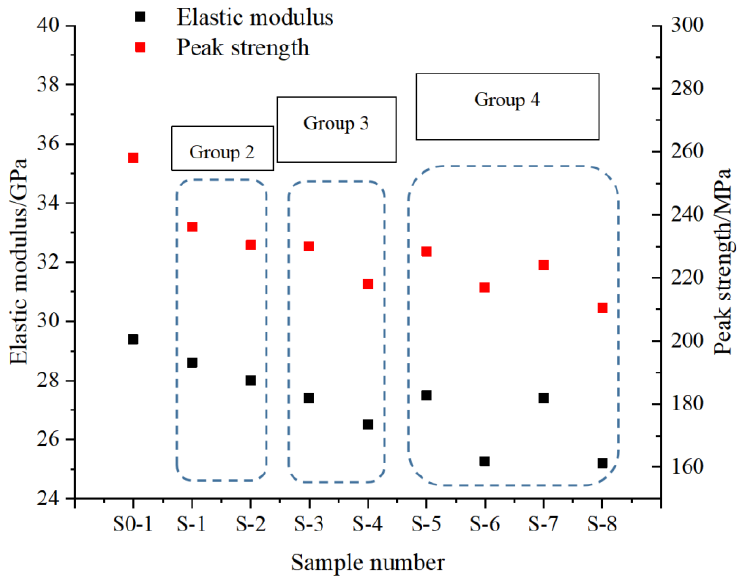
Figure 10. Elastic modulus and peak strength of granite under different types of stimulation treat- ment.